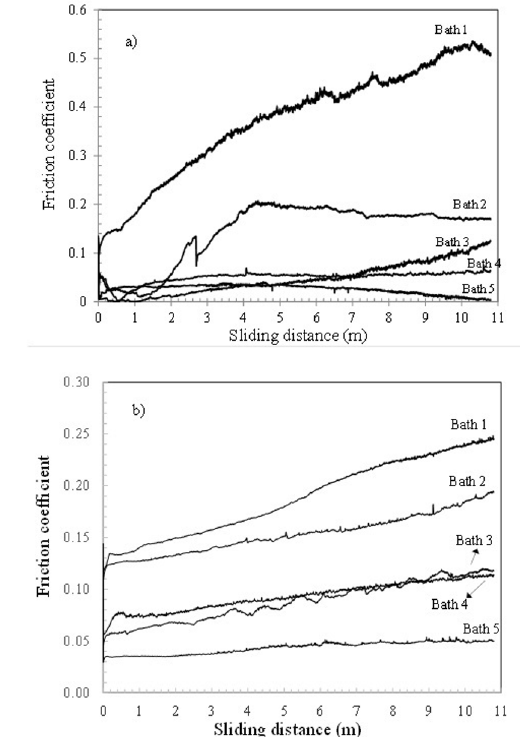
Figure 10. Friction coefficient versus sliding distance during reciprocating wear tests for the coatings obtained in baths with different tungsten concentrations: a) As-deposited; b) annealed at 400 ºC for 1 h.